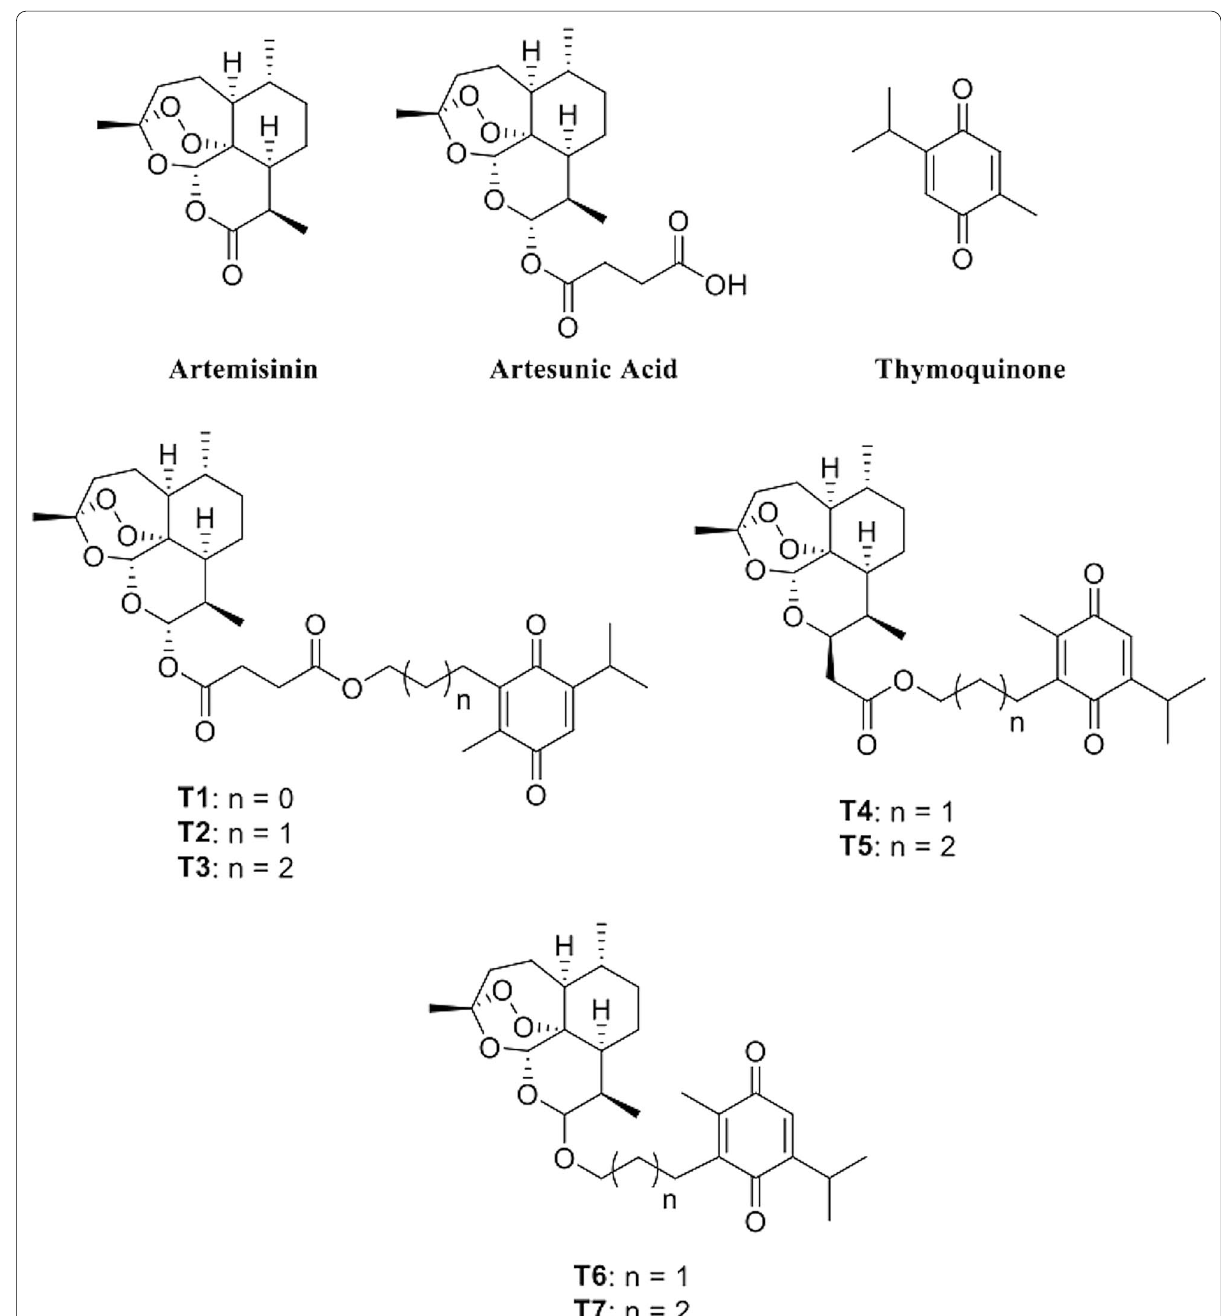
Fig. 1 Structural formula of parental ligands artemisinin, artesunic acid and thymoquinone and synthetic hybrids from artemisinin–thymoquinone T1–7. Adapted from Fröhlich et al. 2018